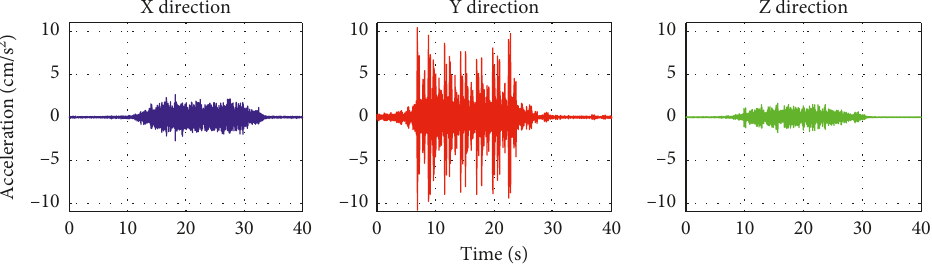
Figure 7: The time-history of measuring point W1 in three directions for metro